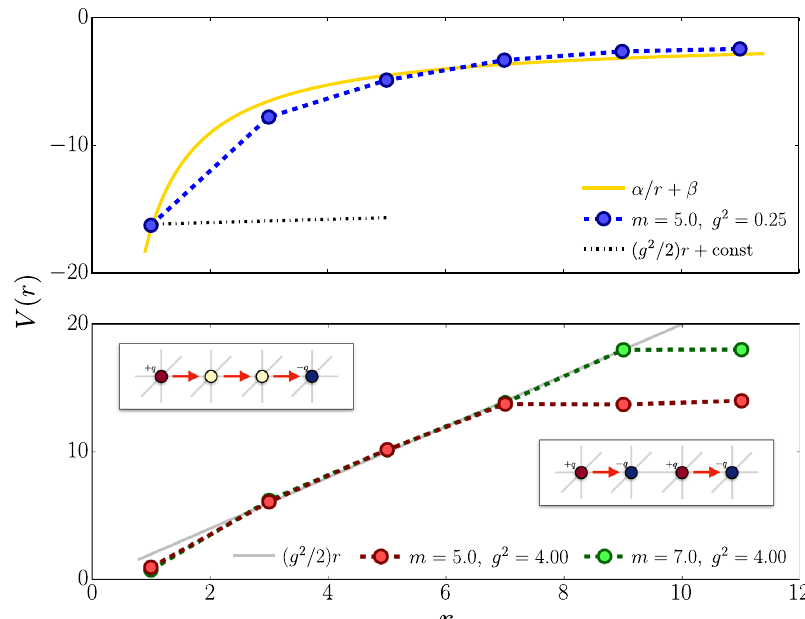
Fig. 4 Con fi nement properties. Interaction potential V ( r ) between two charges of opposite sign as a function of their distance r in the (upper panel) weak coupling regime g ≪ 1 and (lower panel) strong coupling regime g ≫